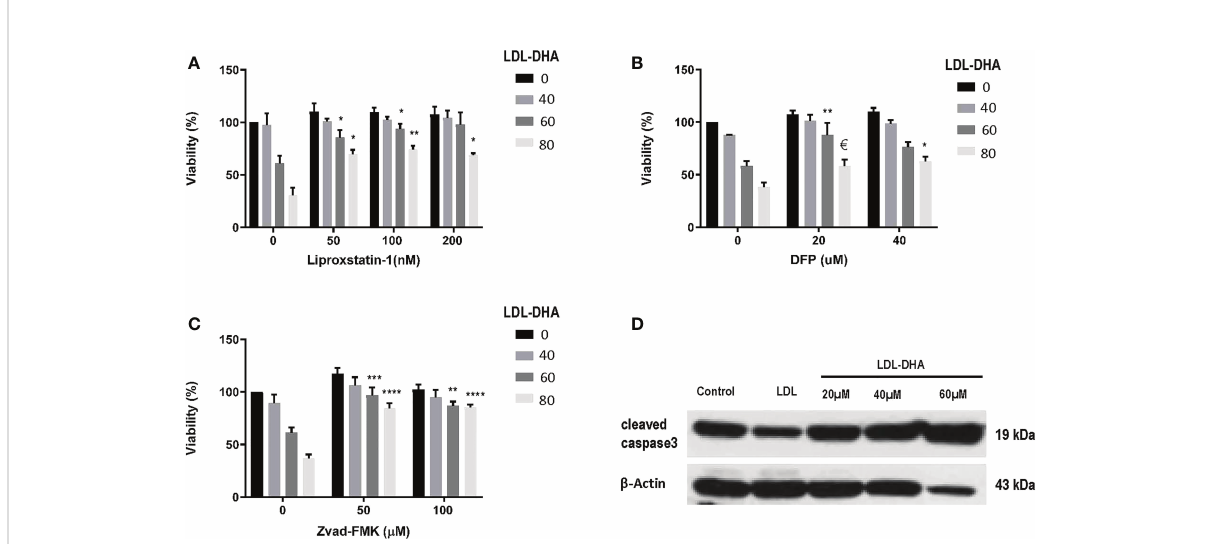
FIGURE 2 Identifying cell death pathways mediated by LDL-DHA cytotoxicity. Cells were treated with LDL-DHA (0, 40, 60, 80 m M) for 24 h in the absence/ presence of: (A) liproxstatin (0, 50, 100, 200 m M); (B) DFO (0, 20, 40 m M); or (C) Zvad-FMK (0, 50, 100 m M). Cell viability (left panel) was measured by MTS assay at 24 hours after LDL-DHA treatment. Results are expressed as mean ± SEM (n=3). *, P <0.05; **, P <0.01; ***, P <0.001; ****, P<0.0001, € , P= 0.065 compared with corresponding LDL-DHA only treatment group. (D) Immunoblot of protein expression levels of cleaved caspase 3 in untreated and treated N1S1 hepatoma cells 24hours after LDL (control) or LDL-DHA (20, 40 and 60 µM)